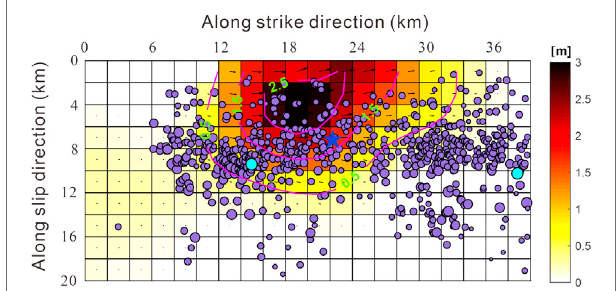
FIGURE11| Faultslipmodelofthemainfaultandaftershocks.Redlines represent the contour of the slip; the blue star represents the mainshock location determined by Yang et al. (2022); the cyan circles denote two aftershocks with magnitude ≥ 5.0.